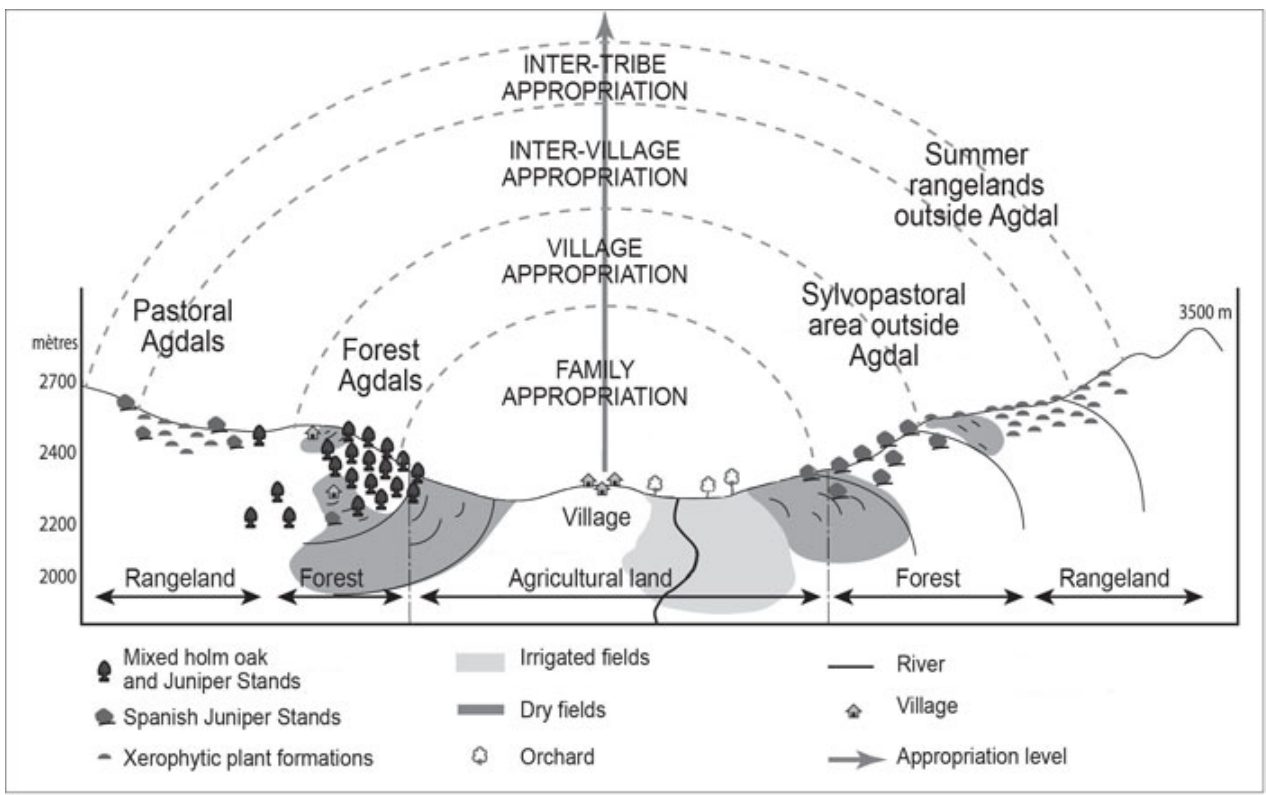
Fig. 3 . Cross section of the main resource spaces and appropriation levels in the upper valley of the Aït Bouguemmez (adapted from Romagny et al.